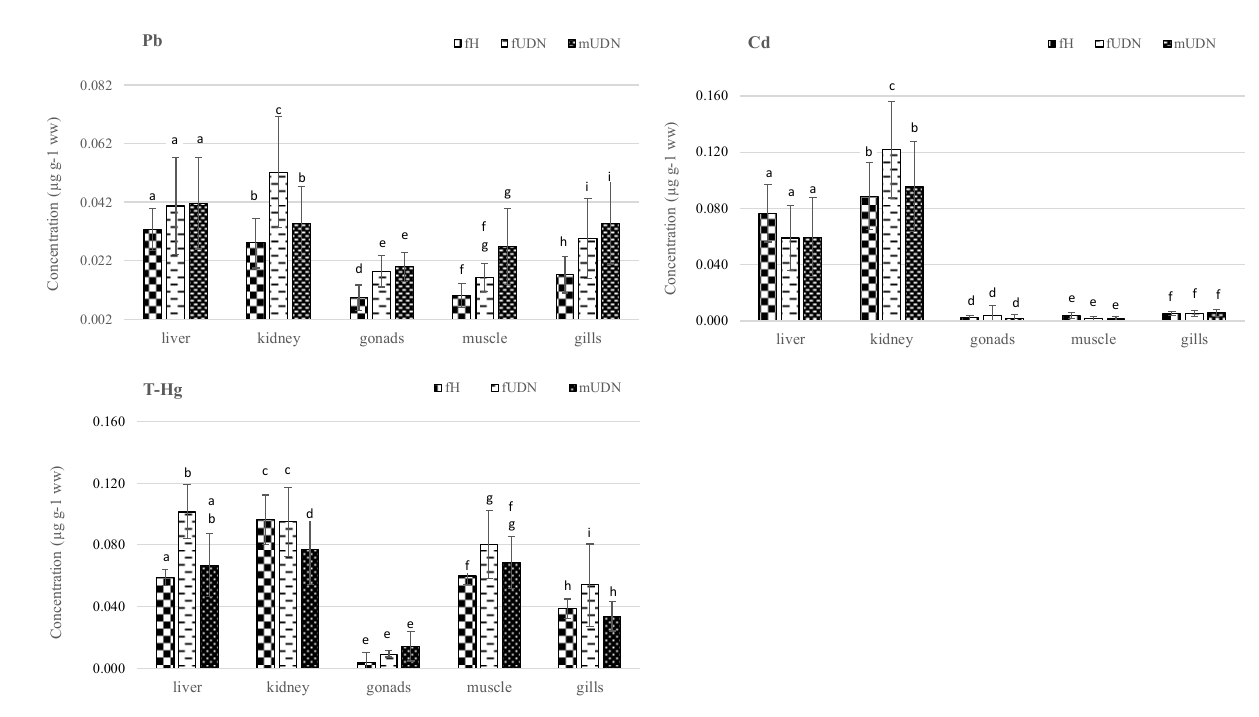
Figure 2. Differences in metal (Pb, Cd, Hg) content in organs of sea trout depending on health status. fH—females without symptoms of disease; fUDN—females with symptoms of disease; mUDN— males with symptoms of disease. a–h Different letters for the same organs indicate significant inter-group differences in metal concentration (Duncan’s test comparison of means, p < 0.05).